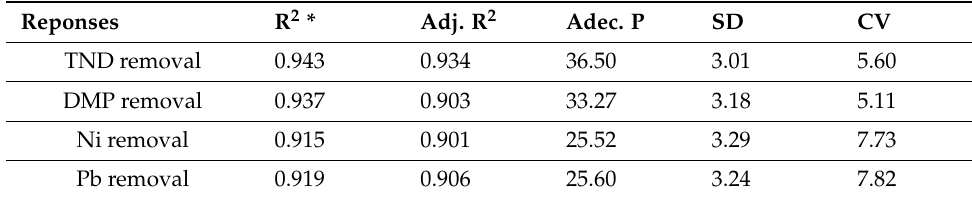
Table 3. Statistical analysis results for response parameters in RSM and